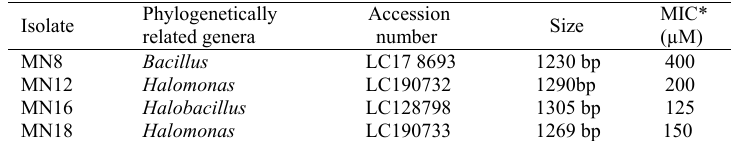
Table 1: Isolation and characterization of the halophilic bacteria moderately resistant to mercury from Gavkhuni wetland in Iran Isolate